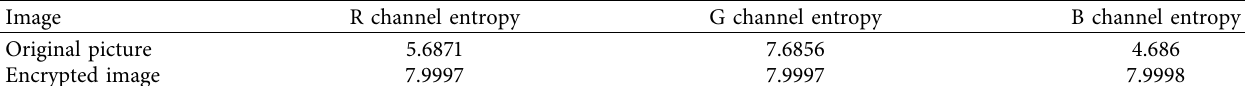
Table 2: The information entropy of the three channels in the original and encrypted on the pepper image.